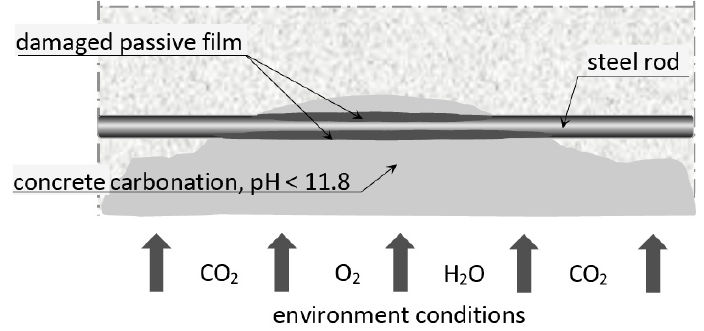
Figure 3. Reinforcement corrosion caused by carbonation of the concrete cover [own study].